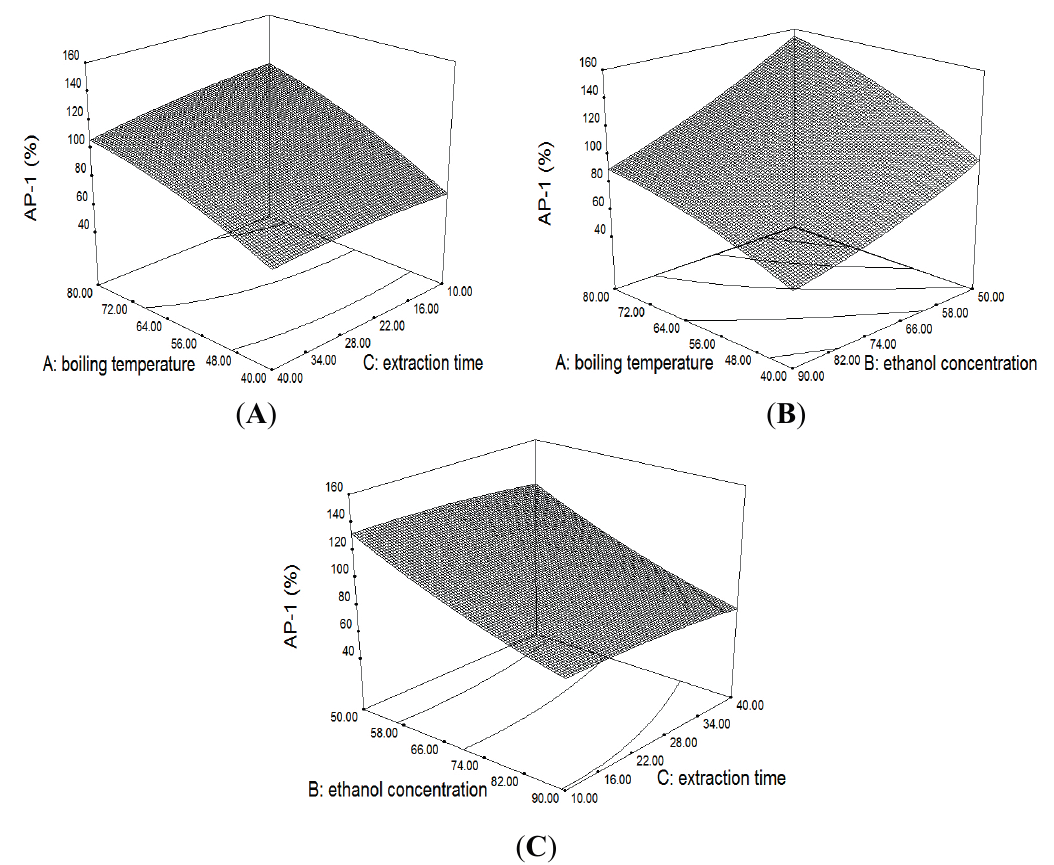
Figure 3. 3D surface and contour plot showing the effect of variables on the extraction yield of AP 1